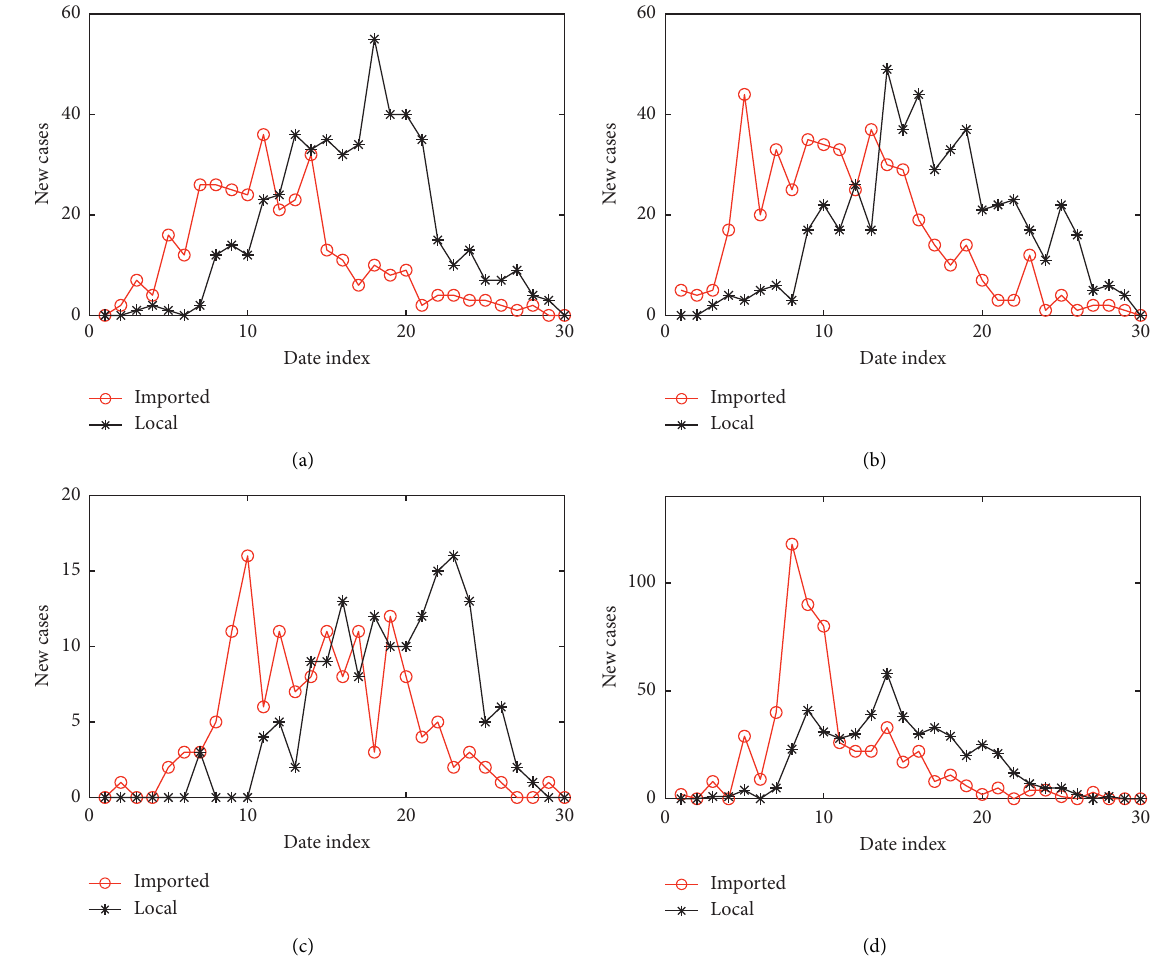
Figure 2: The number of imported and local confirmed cases changing with time for (a) Anhui Province (831 cases), (b) Henan Province (967 cases), (c) Jiangsu Province (299 cases), and (d) Zhejiang Province (1051 cases). The red and black curves are the imported and the local cases, respectively. Table 2: The top three infector-infectee relationships within family members based on 411 confirmed cases. Relationship Couples